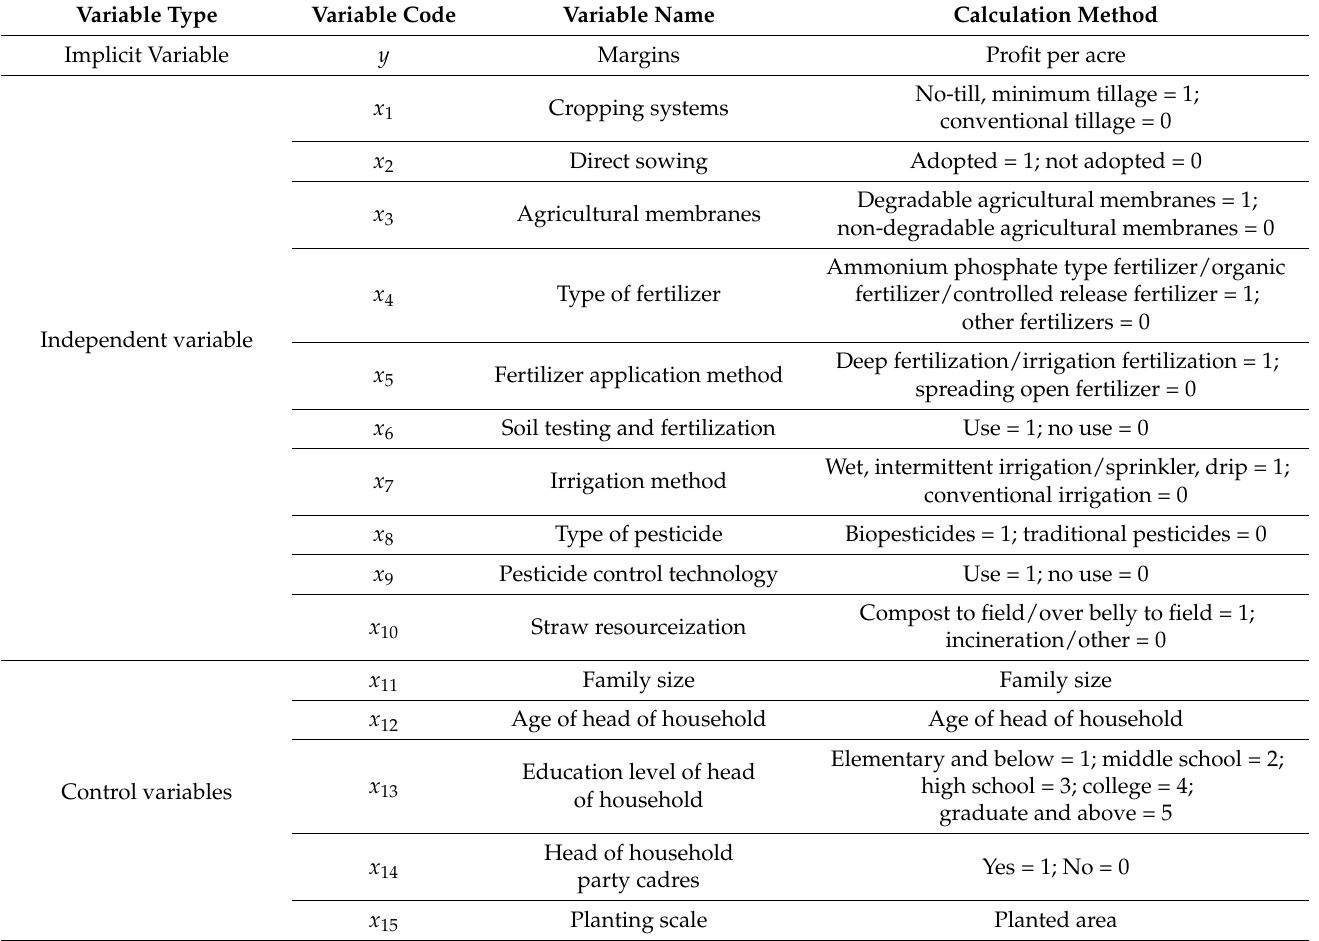
Table 2. Variable